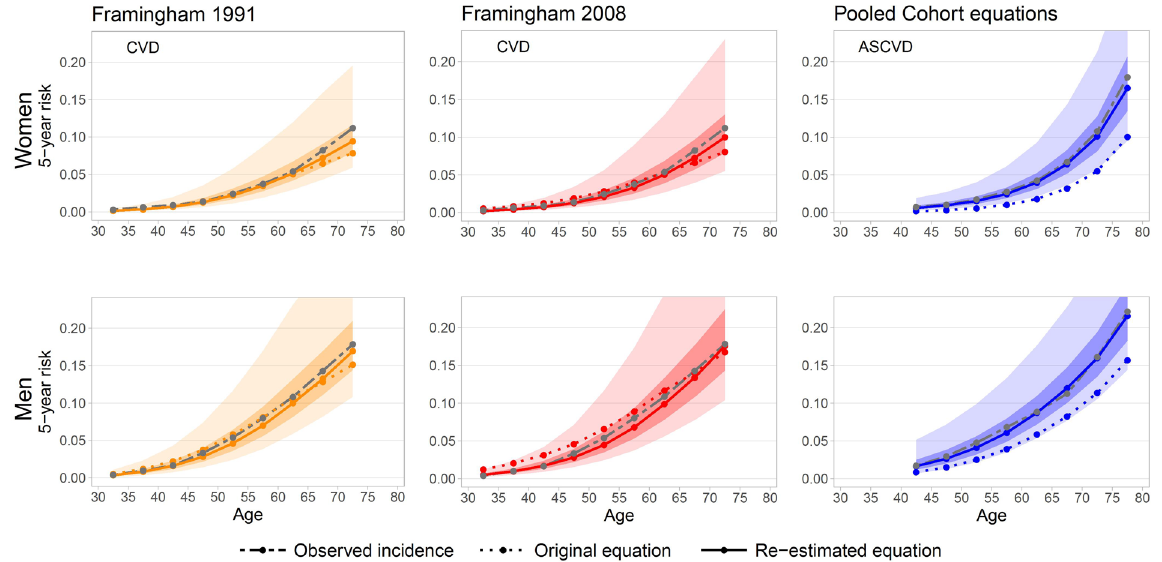
Figure 4. Median predicted five-year CVD risk for different age groups for women and men. Dashed, gray lines visualize the observed incidence, dotted lines show predictions from the original equations, and continuous lines give predictions from the re-estimated equations. The range from the 2.5th to the 97.5th and the 25th to the 75th percentile of the predicted five-year risk are visualized as shaded areas for the re-estimated equations. (The largest estimated 97.5 th percentile of the estimated five-year risk was 32.5% for women and 37.4% for